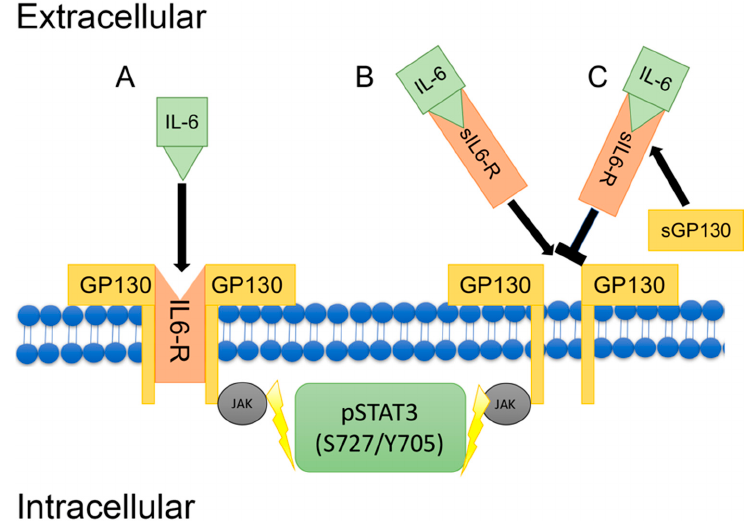
Figure 5. Classical versus interleukin-6/(IL-6) trans-signaling. A simplified schematic depicts classical IL-6 signaling whereby IL-6 binds to membrane-bound IL-6 receptor (IL-6R) initiating signal transduction via glycoprotein 130 (GP130) to increase intracellular STAT3 via JAK ( A ); Alternatively, in ( B ) IL-6 trans-signaling occurs whereby IL-6 binds to soluble IL-6 receptor (sIL-6R) which then complexes to membrane-bound GP130/JAK to initiate STAT3 signal transduction. Inhibition of IL-6 trans-signaling can occur by the decoy soluble GP130 (sGP130) ( C ).